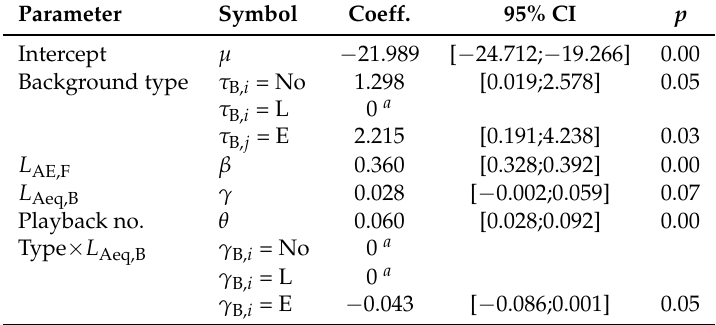
Table 4. Experiment 2: model coefficients (Coeff.), their 95% CI, and probabilities ( p ) of the linear mixed effects model for annoyance. The parameters and symbols are explained in Equation (3).